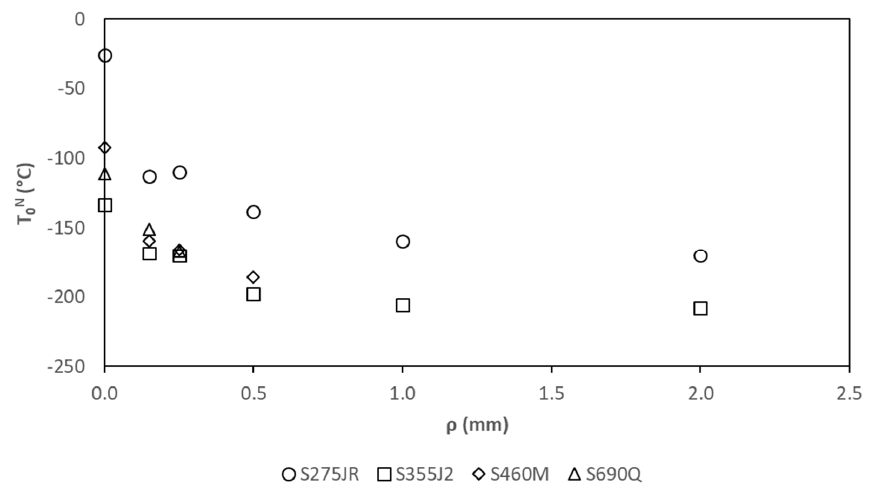
Figure 7. Evolution of the apparent reference temperature (T 0N ) with the notch radius for the four structural steels being analyzed.